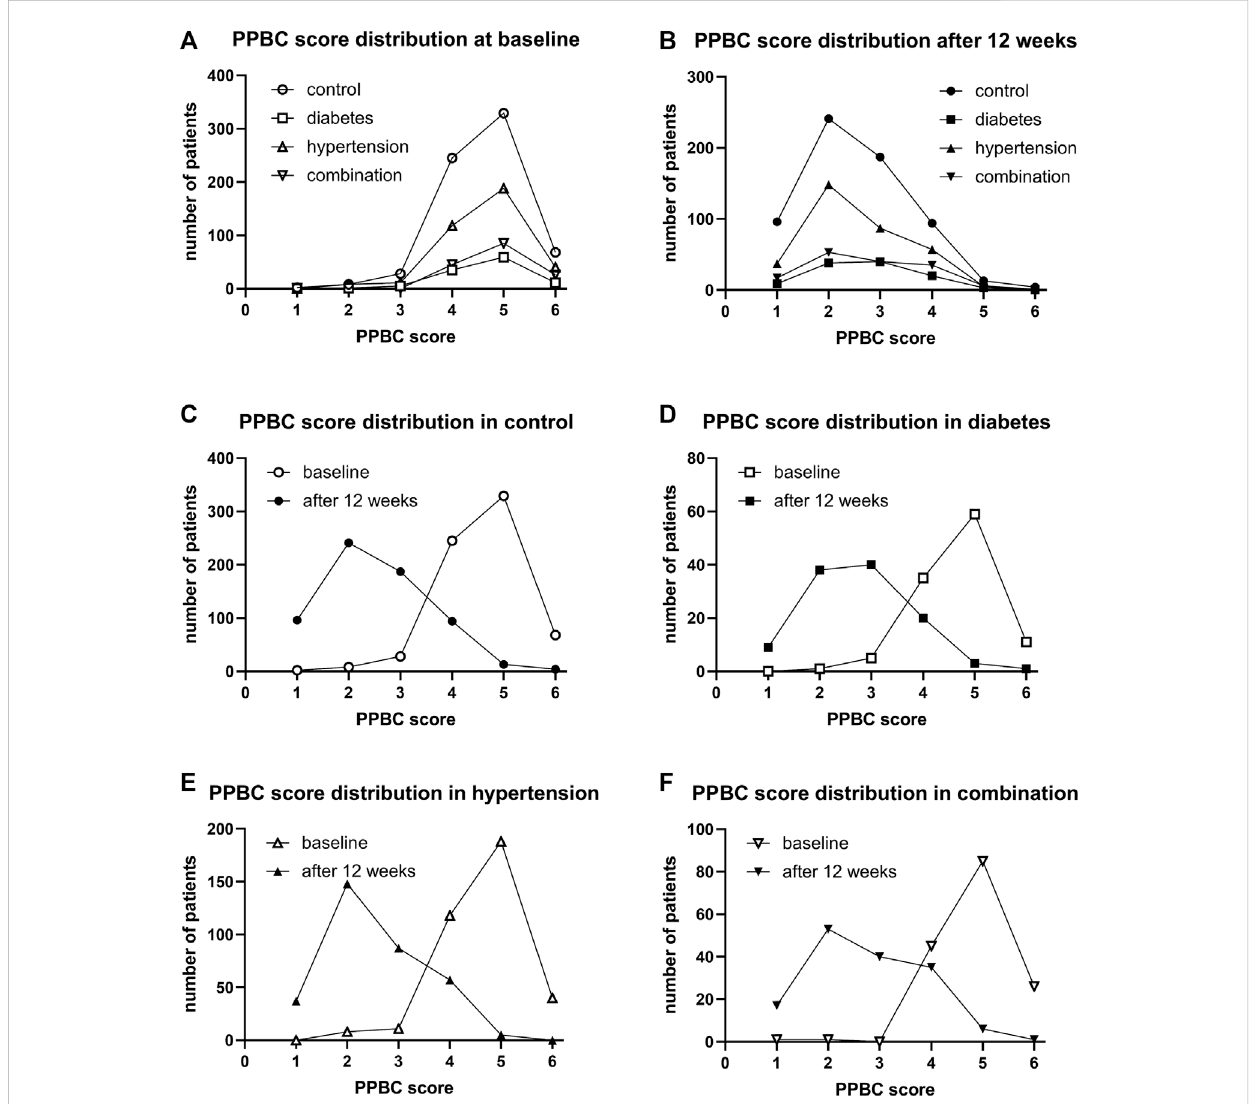
Frequency distribution of the PPBC score in study I: (A) across groups at baseline, (B) across groups after 12 weeks of treatment, (C) comparison of baseline and after 12 weeks of treatment in control patients, (D) comparison in diabetic patients, (E) comparison in hypertensive patients, and (F) comparison in patients with both